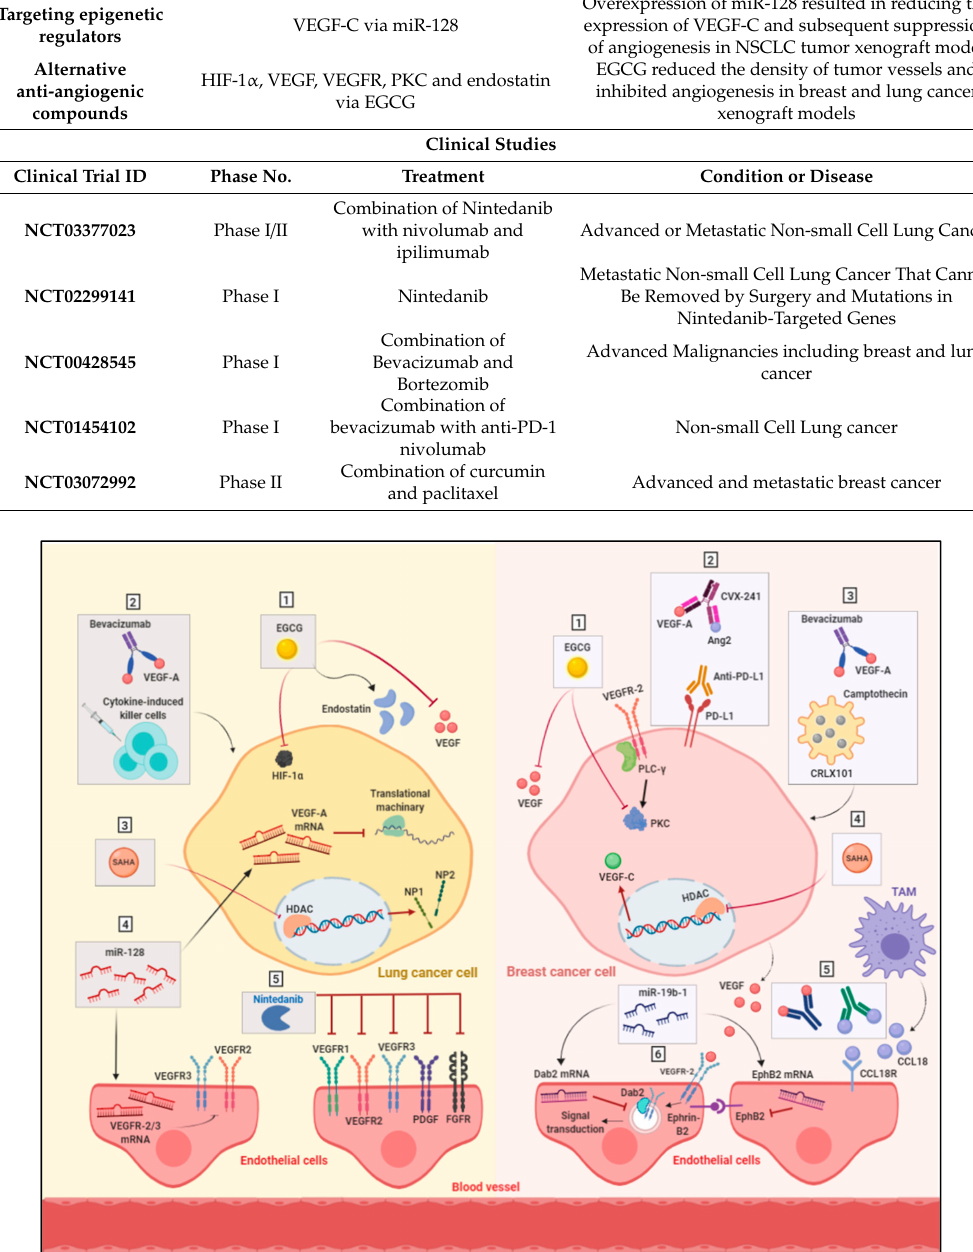
Figure 2. Strategies to overcome anti-angiogenic therapy resistance. Resistance to anti-angiogenic drugs in lung cancer (right) could be delayed by ( 1 ) the natural compound EGCG, which exerts its antiangiogenic e ff ect by suppressing the expression of VEGF-A and HIF-1 α and increasing the expression of angiogenesis inhibitor endostatin in cancer cells; ( 2 ) the combination of bevacizumab